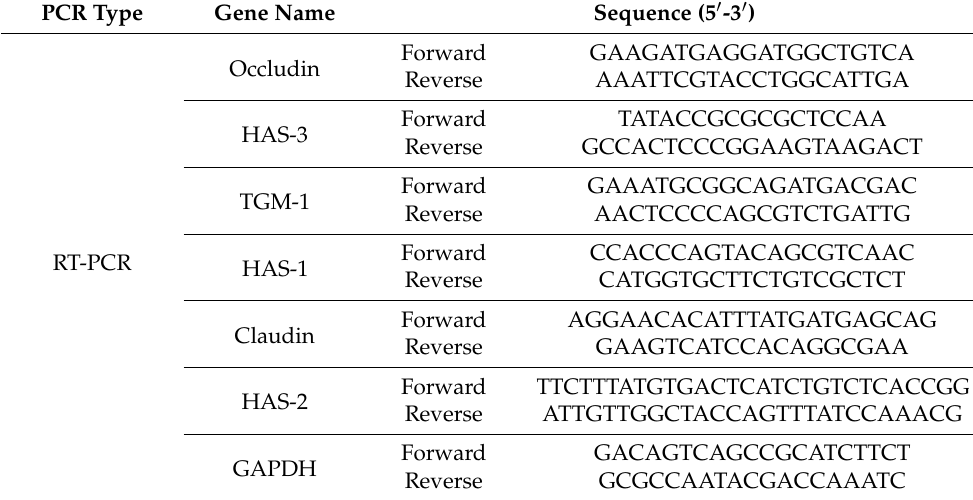
Table 1. List of primers synthesized for